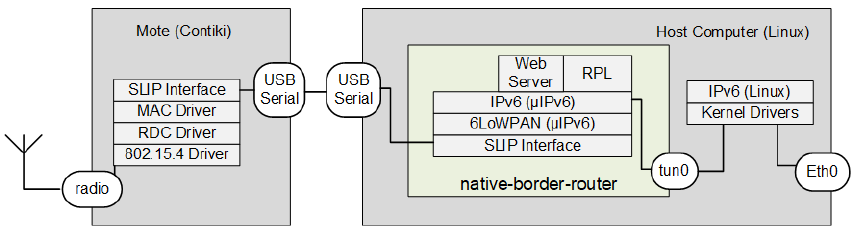
Figure 10. Linux host computer connected to a USB mote 6LBR option. SLIP, serial line IP.